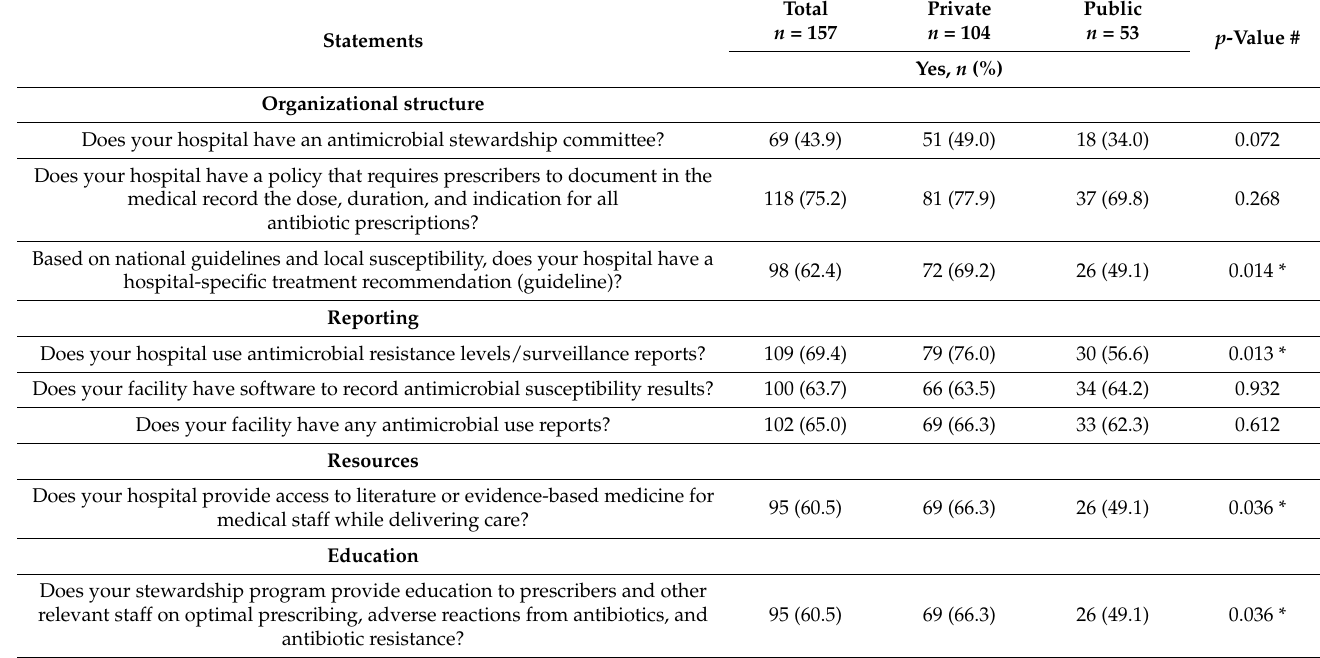
Table 2. The level of implementation of antimicrobial stewardship activities ( n =